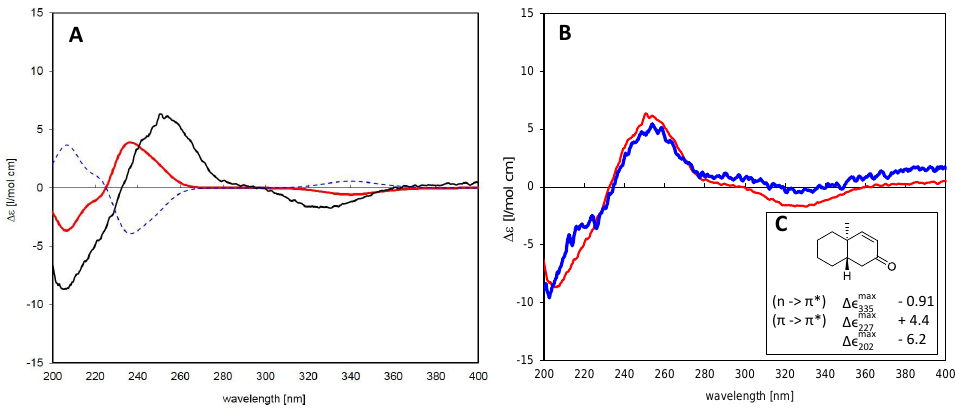
Figure 3. ( A ) Time-dependent density functional (TDDFT) calculated CD spectra for Compound 3 as a normal pimarane (blue, dashed) and ent -pimarane (red) in comparison with the experimental spectrum of the isolated compound (black); ( B ) comparison of CD spectra of Compounds 1 (blue) and 3 (red). Both compounds show essentially the same Cotton effects, so that they belong to the same series of diterpenes; ( C ) Correlation between the Cotton effect sign of a model enone in heptane that corresponds to the same absolute configuration as that observed in Compounds 1 and 3 (adapted from Lightner et al.